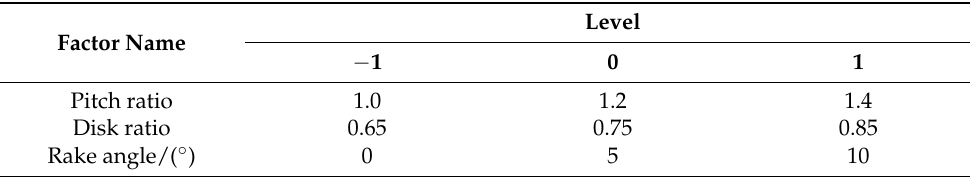
Table 6. Factors and levels affecting the open water efficiency.